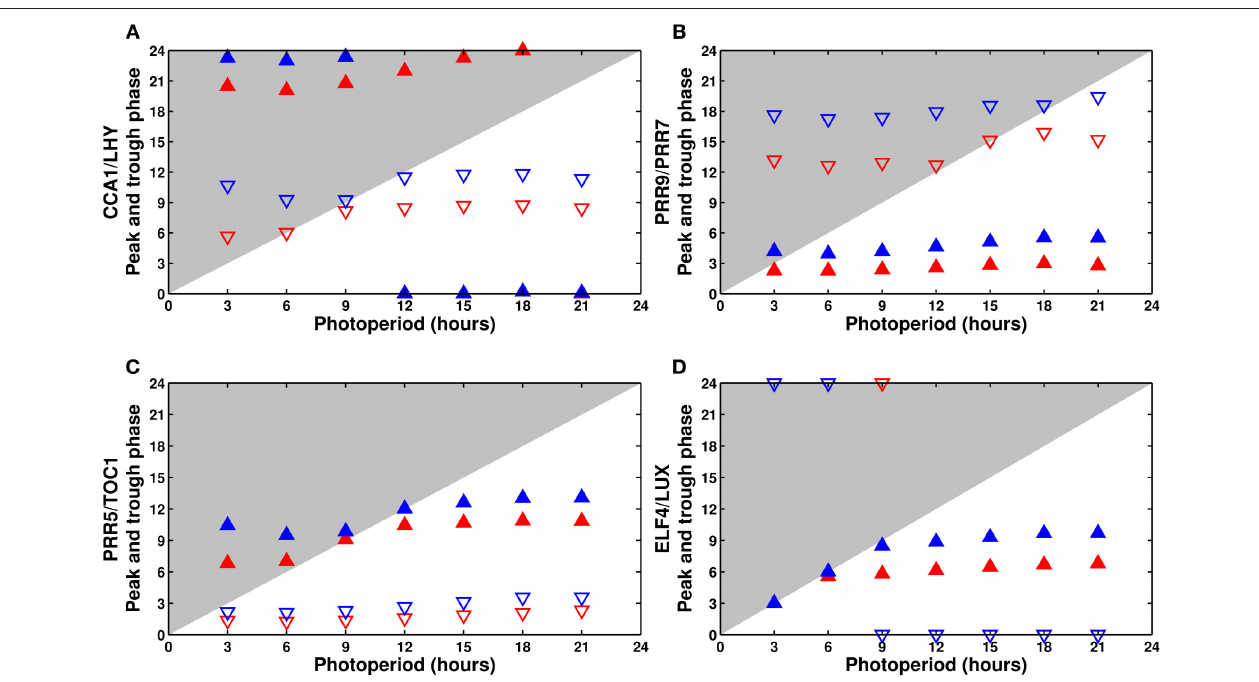
FIGURE 6 | Phase dependence on the photoperiod: (A) CCA1/LHY, (B) PRR9/PRR7, (C) PRR5/TOC1, and (D) ELF4/LUX. Phase of the peak (filled upward triangles) and trough (empty downward triangles) of the model components as a function of the photoperiod. The wild type is in blue, the cca1 mutant in red. The typical phase advance of the mutant is clearly